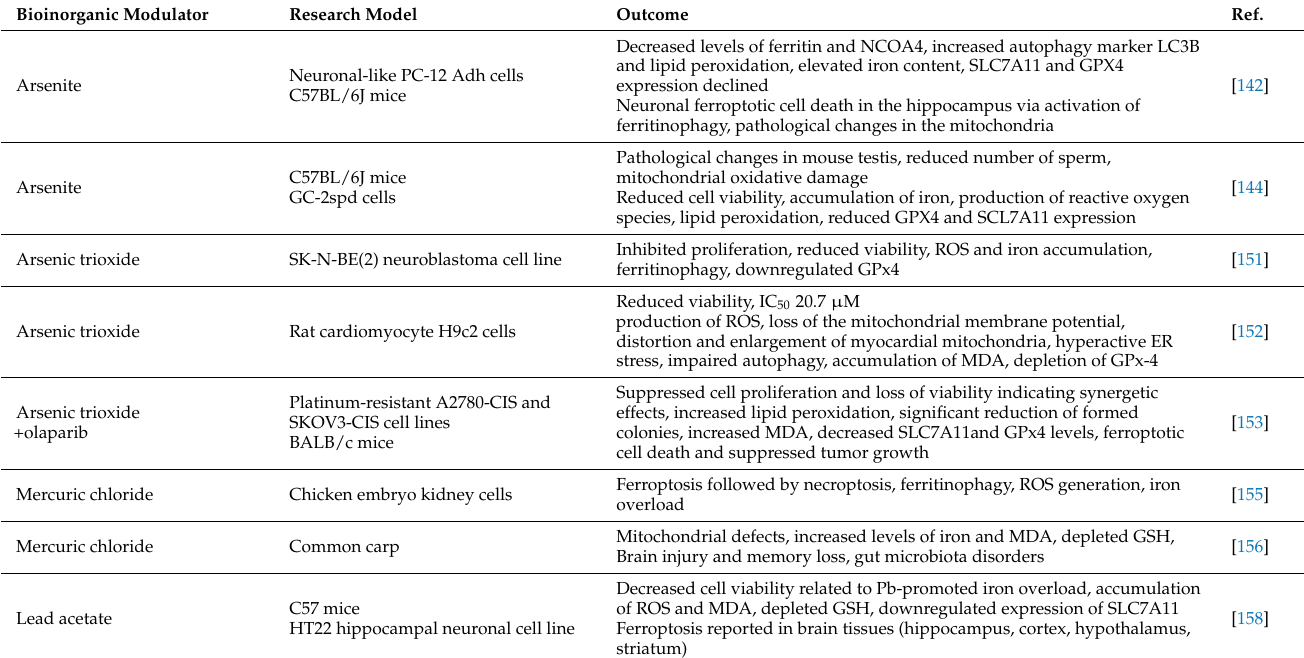
Table 4. Recapitulation of the toxic compounds and their modulatory effect on ferroptosis-related cell survival and